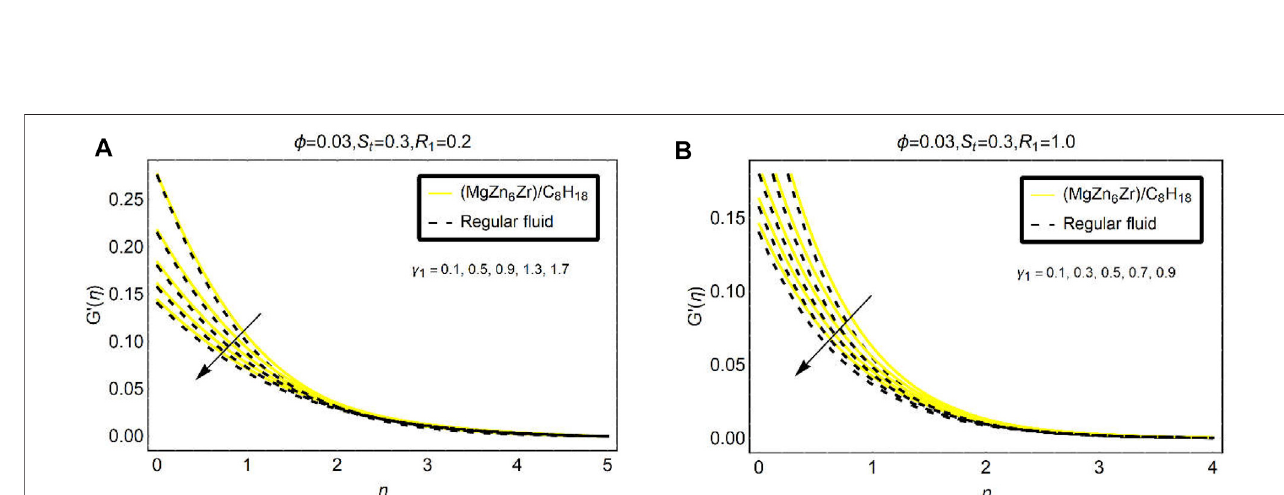
FIGURE 8 | Velocity G ’ via γ 1 (A) R 1 (cid:2) 0 . 2 and (B) R 1 (cid:2) 1 . 0.